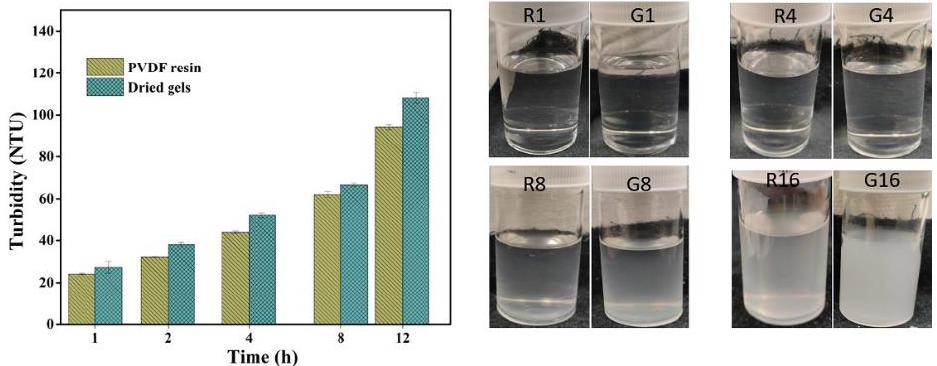
Figure 5. Solution stability test of resins (R) and gels (G) (the numbers represent the storage time in hours).